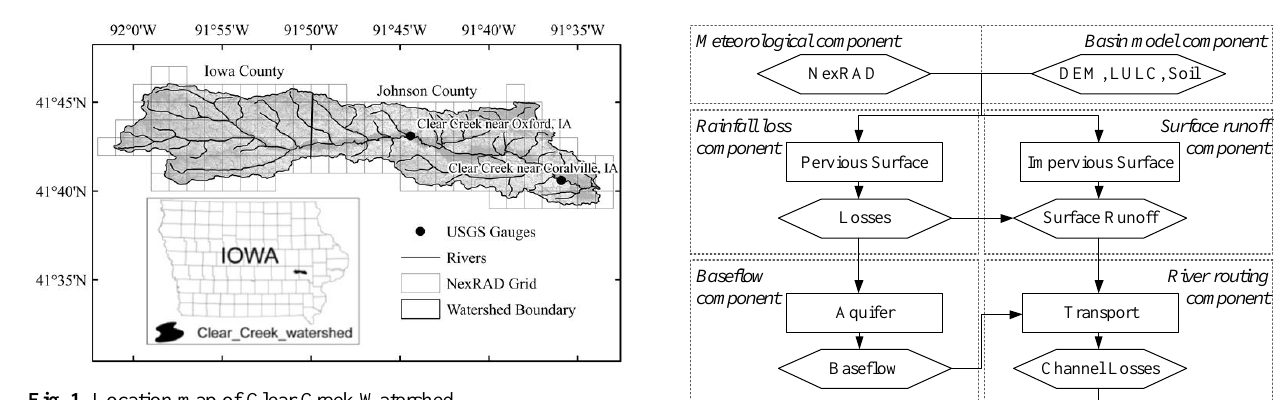
Fig. 1. Location map of Clear Creek Watershed. Figure 1. Location map of Clear Creek Watershed 2